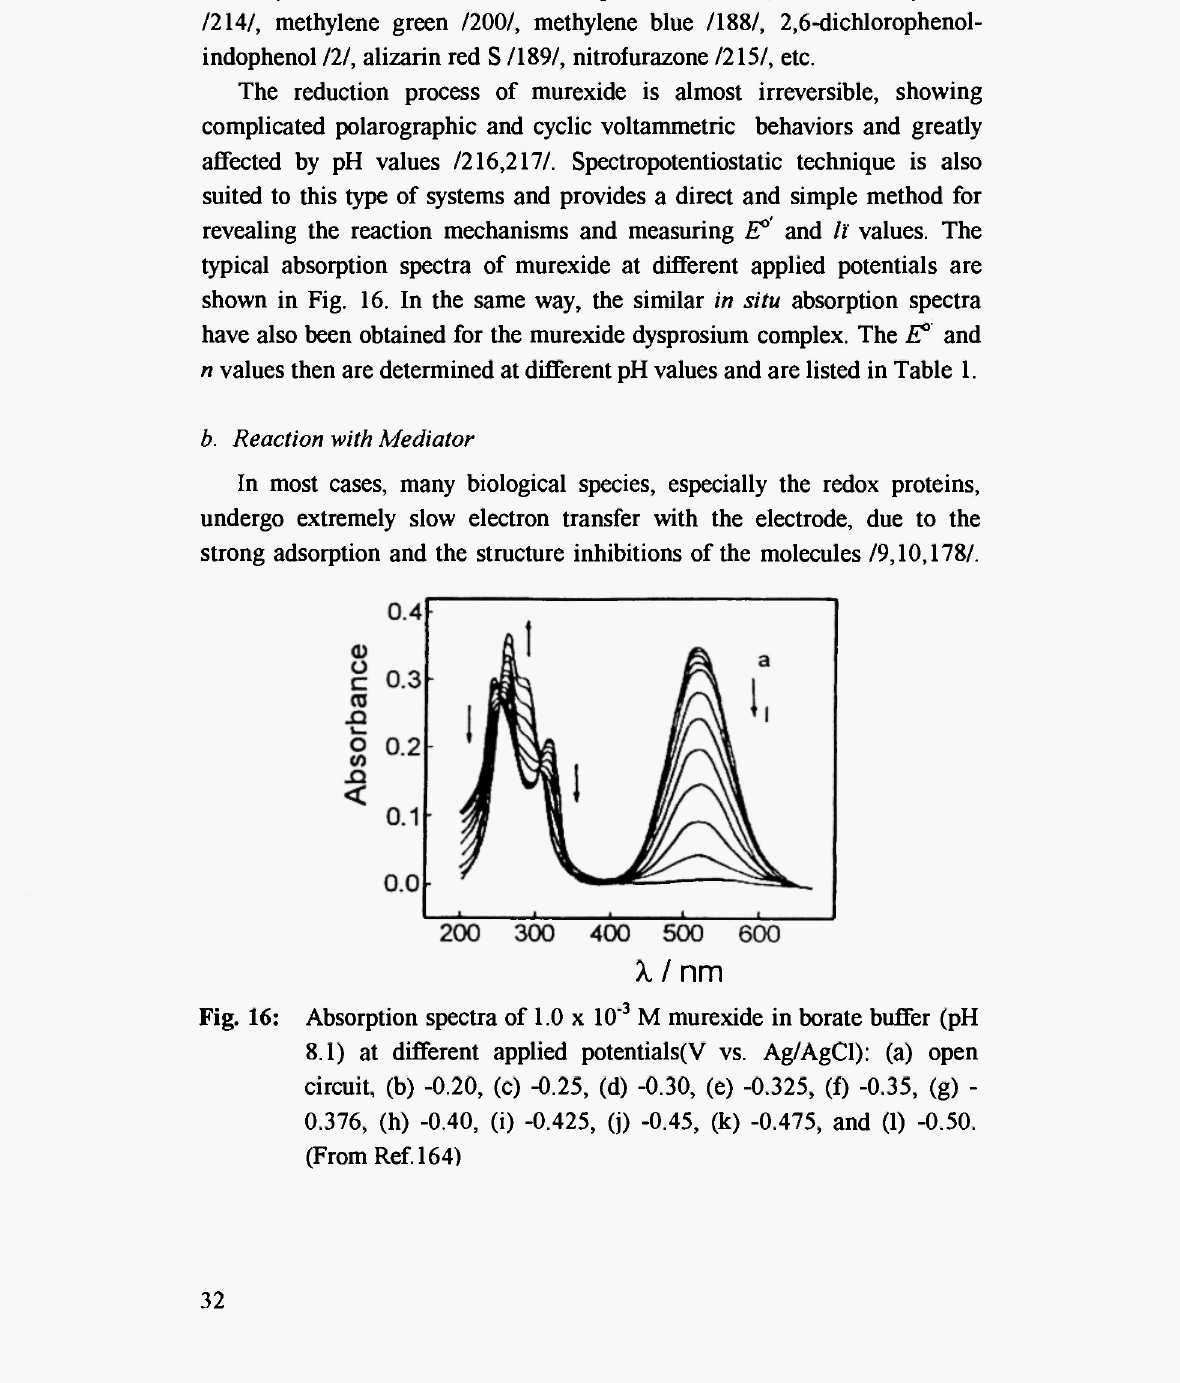
Fig. 16: Absorption spectra of 1.0 χ 10" 3 Μ murexide in borate buffer (pH 8.1) at different applied potentials(V vs. Ag/AgCl): (a) open circuit, (b) -0.20, (c) -0.25, (d) -0.30, (e) -0.325, (f) -0.35, (g) - 0.376, (h) -0.40, (i) -0.425, (j) "0.45, (k) -0.475, and (1) -0.50. (From Ref.